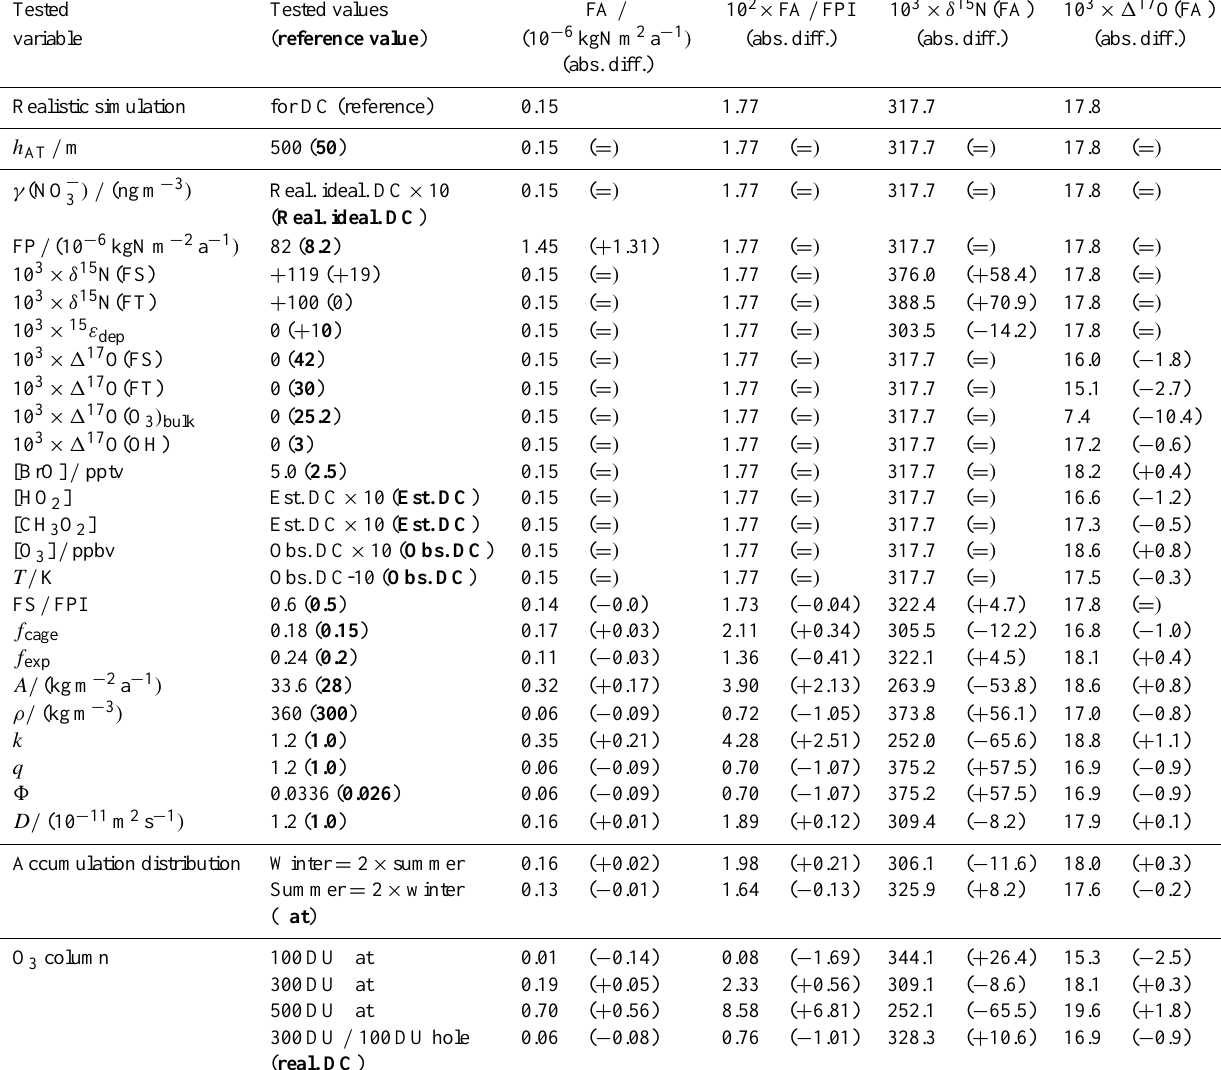
Table 7. Overview of the TRANSITS results for the sensitivity tests. Tested Tested values